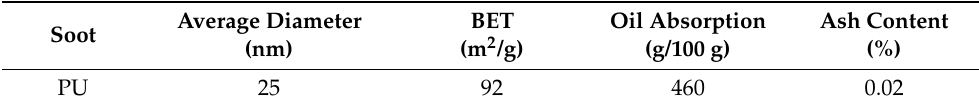
Table 1. Detailed parameters of PU.